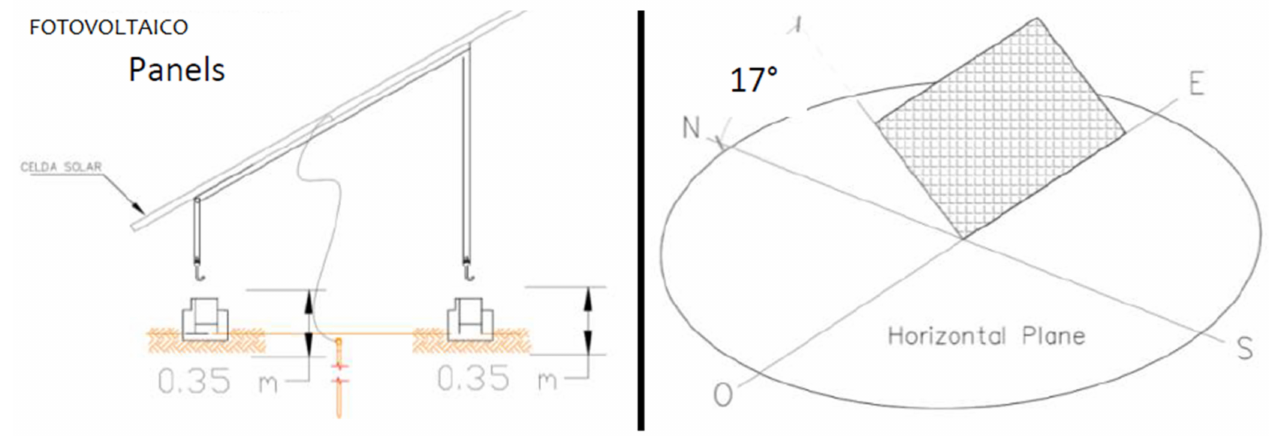
Figure 8. Details of structures and characteristics of the photovoltaic